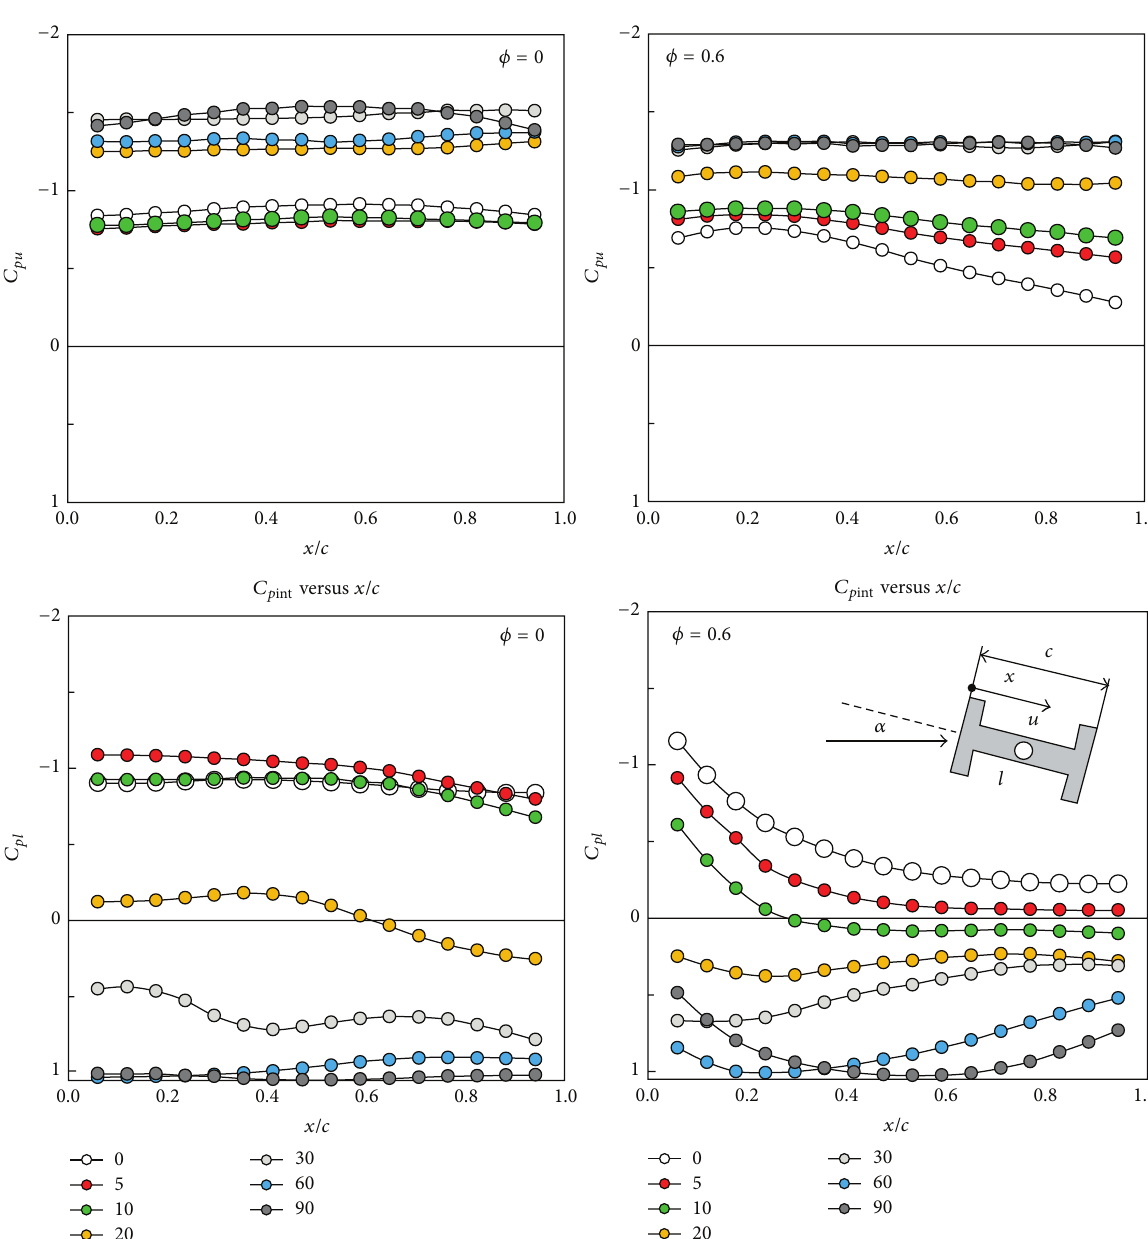
Figure 8: Pressure distributions on the surfaces of the central box of H-section beams. Results on the left column correspond to solid vertical walls, 𝜙 = 0 , and those of the right column to a porosity 𝜙 = 0.6 . Symbols identify the angle of attack according to the keys included in the